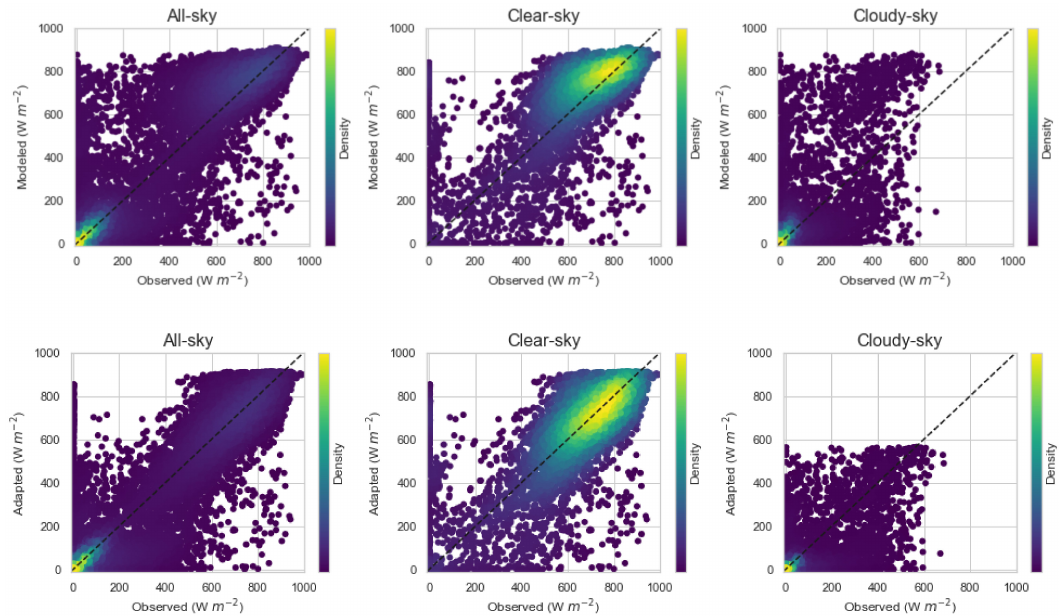
Figure 4. Same as Figure 3, but for